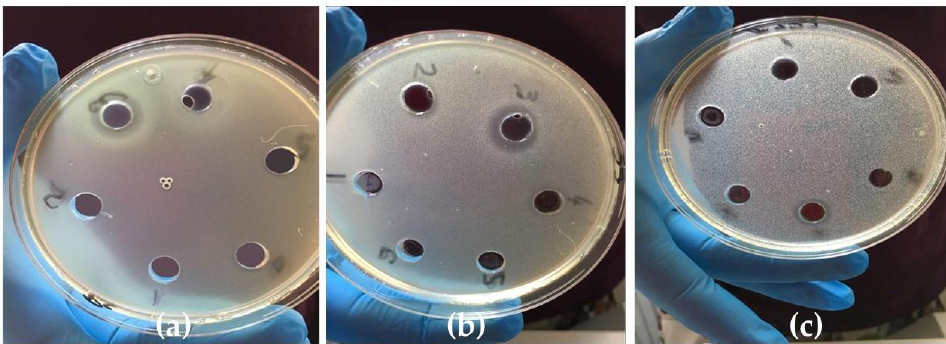
Figure 6. Antimicrobial activity of the hydrogel incorporating the Rosmarini herba extract against ( a ) Staphylococcus aureus ( b ) Pseudomonas aeruginosa and ( c ) Candida albicans. ( a ) Staphylococcus aureus , ( b ) Pseudomonas aeruginosa , and ( c ) Candida albicans. Reference